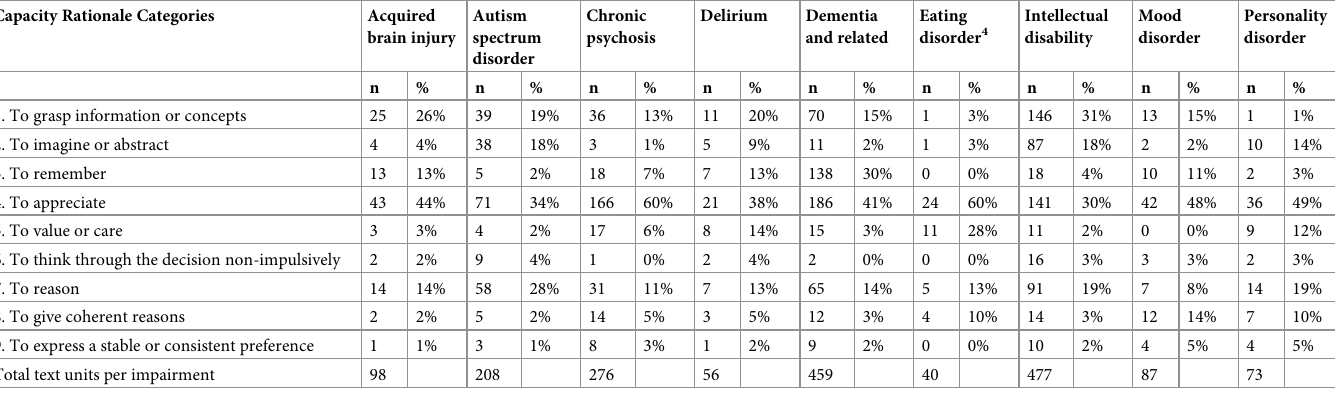
Table 4. Frequency of capacity rationales according to impairment of mind or brain (diagnosis) 1, 2, 3 .